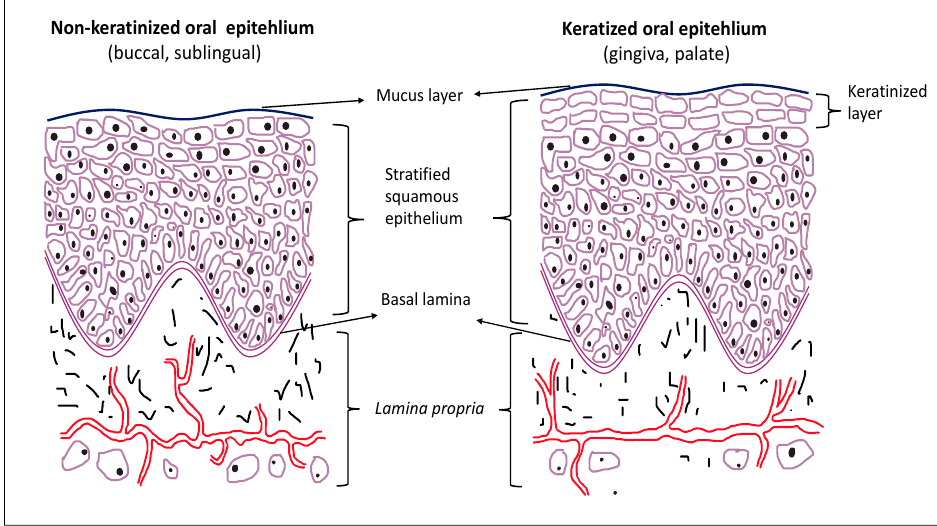
Figure 1. Structure of the oral mucosa. Epithelium is separated and bound with strong integrin bonds to the underlying extracellular matrix tissue by a fibrous basement membrane. Physical barriers are created by the unique architectural integrity of the stratified epithelia, where epithelial cells are interconnected by tight junctions (TJs) (occluding junction), gap junction and anchoring